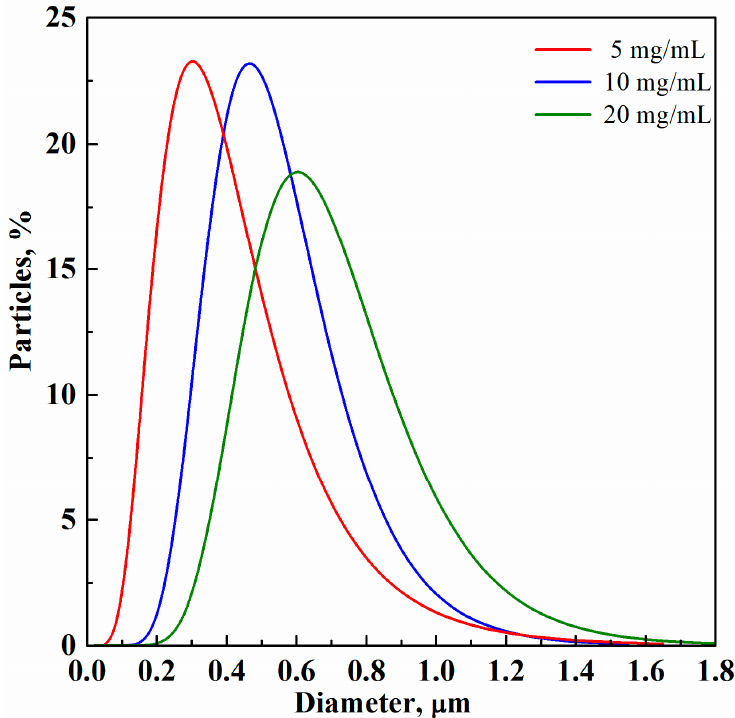
Figure 3. PSDs of sodium alginate microparticles produced via SAA at 80 °C, 82 bar, and GLR = 1.8. The alginate-based microparticle mean diameter varied from 0.30 ± 0.16 µm to 0.60 ±